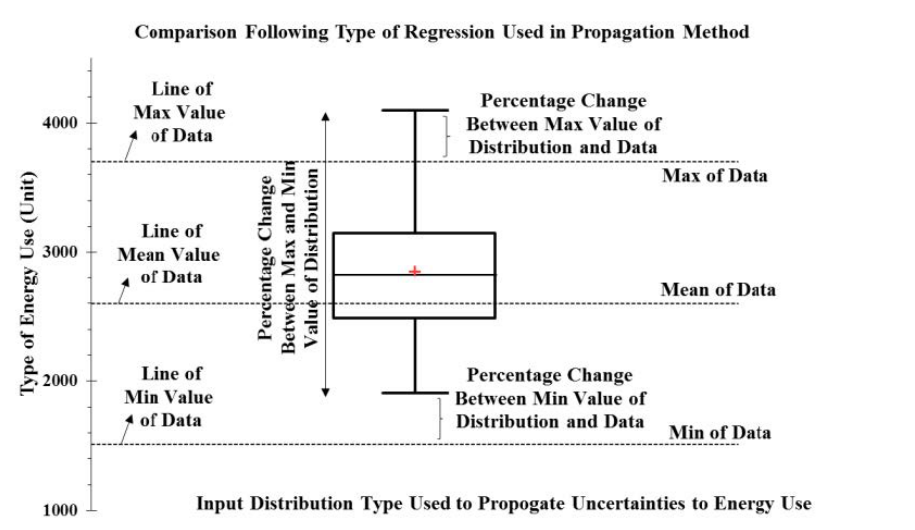
Figure 5. Legend of the figures to interpret output of the impact assessment.